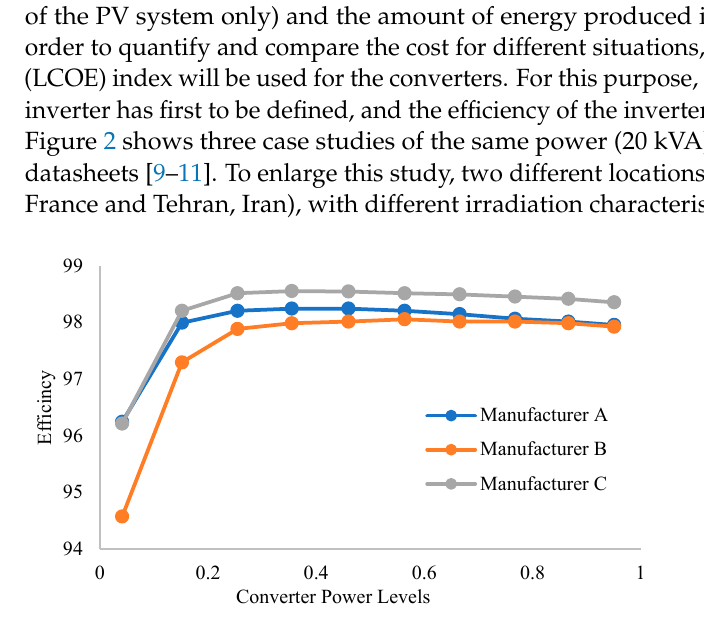
Figure 2. The inverter efficiency curve for three different 20 kVA inverters.